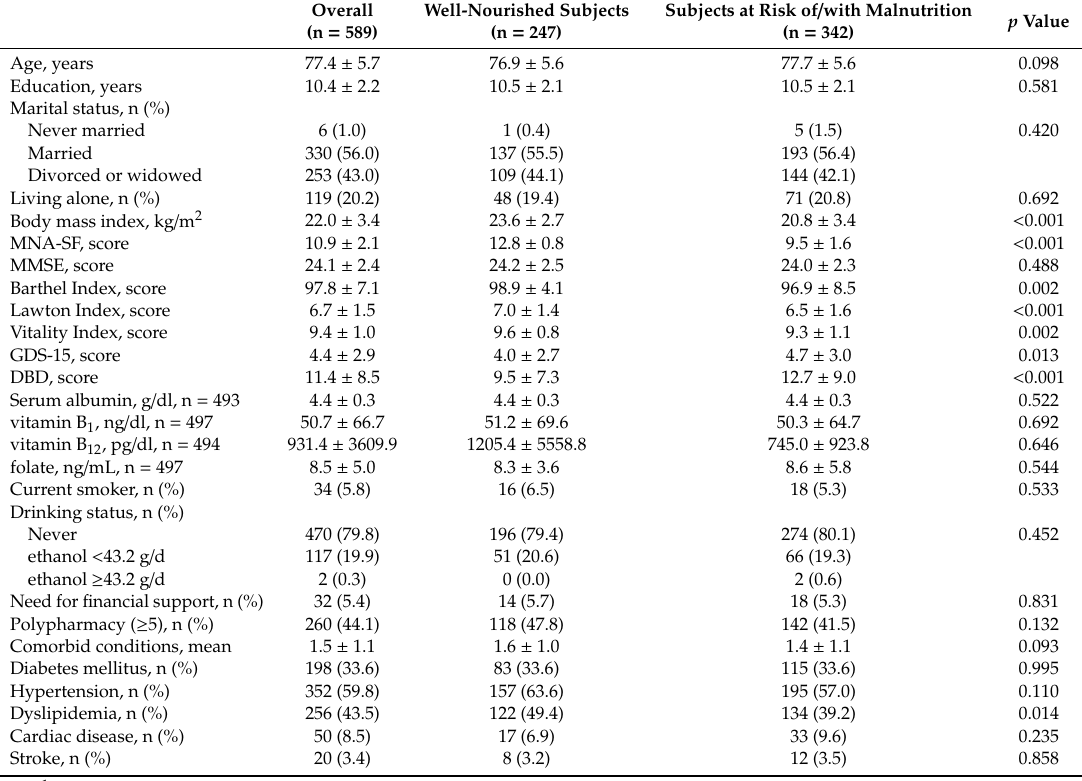
Table 3. Clinical characteristics of subjects with MCI and early-stage AD by nutritional status 1